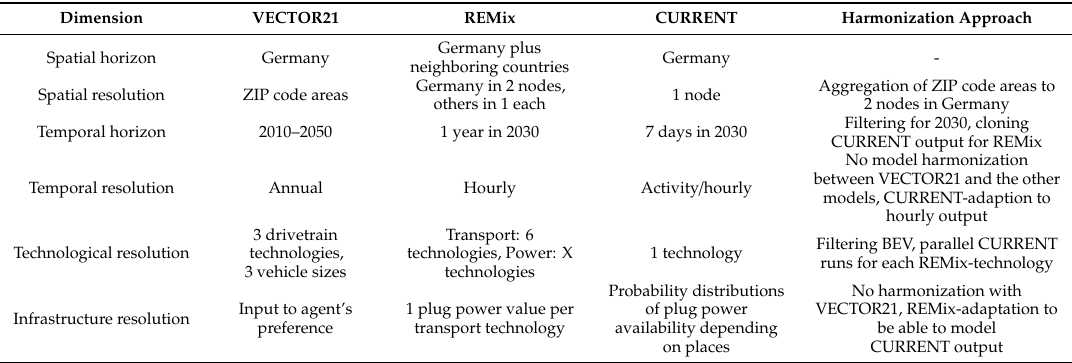
Table 2. Model dimensionality and respective harmonization